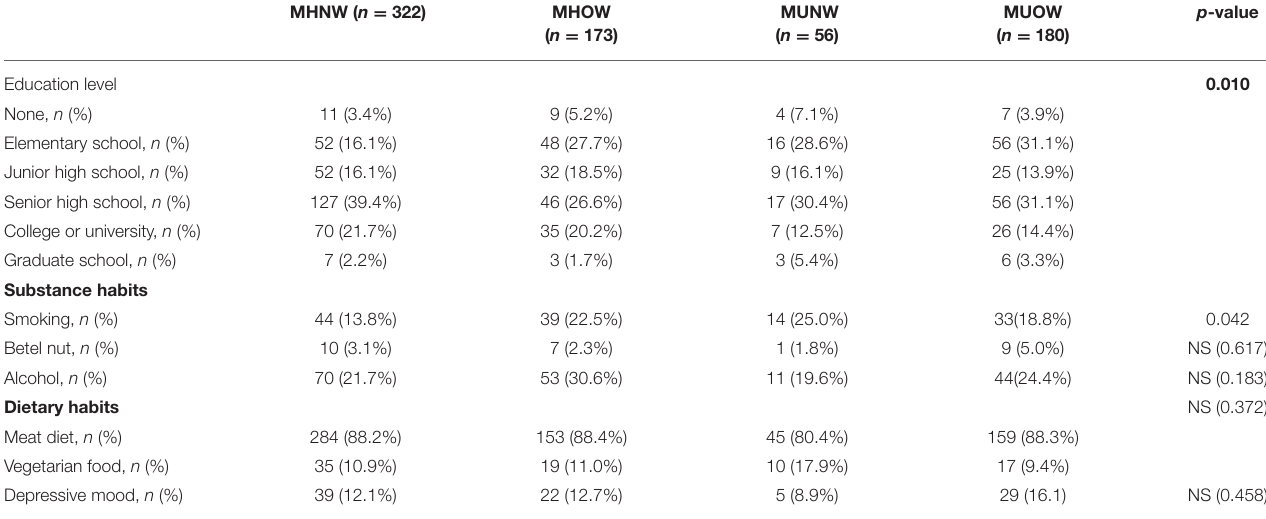
TABLE 3 | Social psychology variables of the study population stratified by metabolic body composition